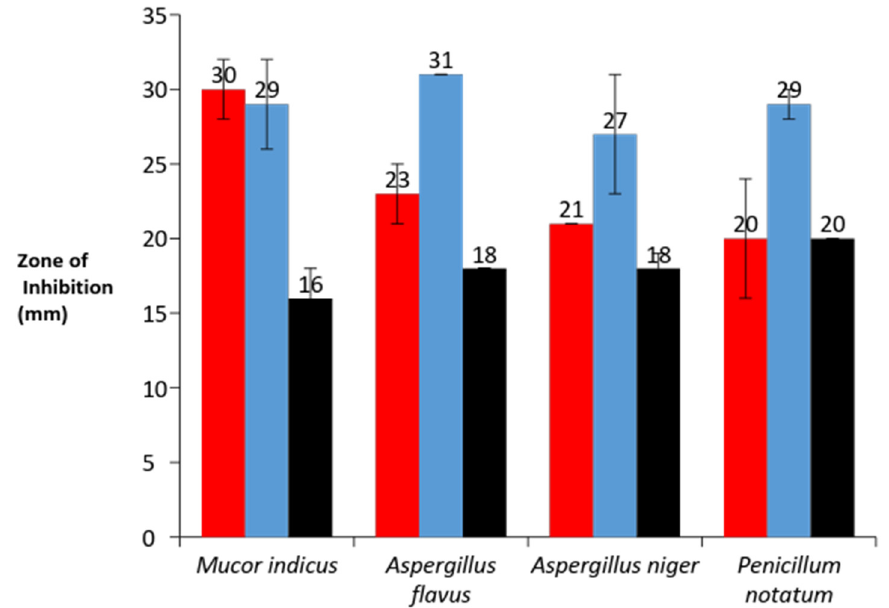
Figure 2. Antifungal potential of A. mexicana aqueous extracts: (1) Mucor indicus ; (2) Aspergillus flavus ; (3) Aspergillus niger ; and (4) Penicillum notatum . Antifungal activity seen within A. mexicana leaf extract (red bar), stem extract (blue bar) while black bars indicate antifungal activity of Amphoterecin-B. Error bars shown on each histogram indicates standard deviation.